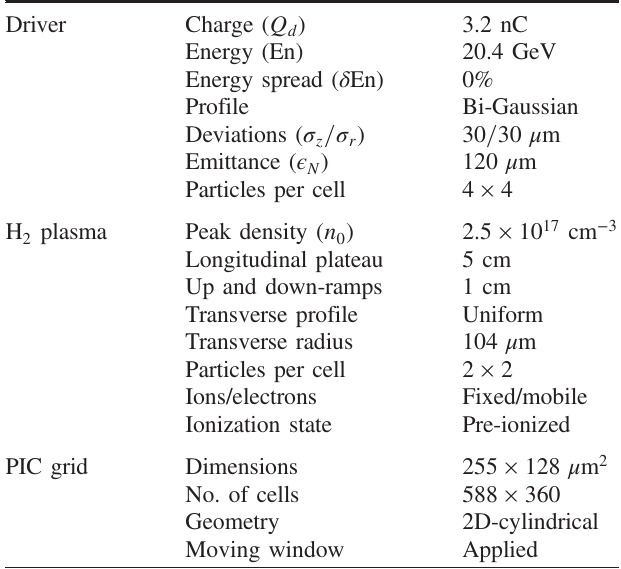
TABLE I. Control simulation driver, plasma, and numerical para- meters for the configuration with long, wide driver (FACET-I).